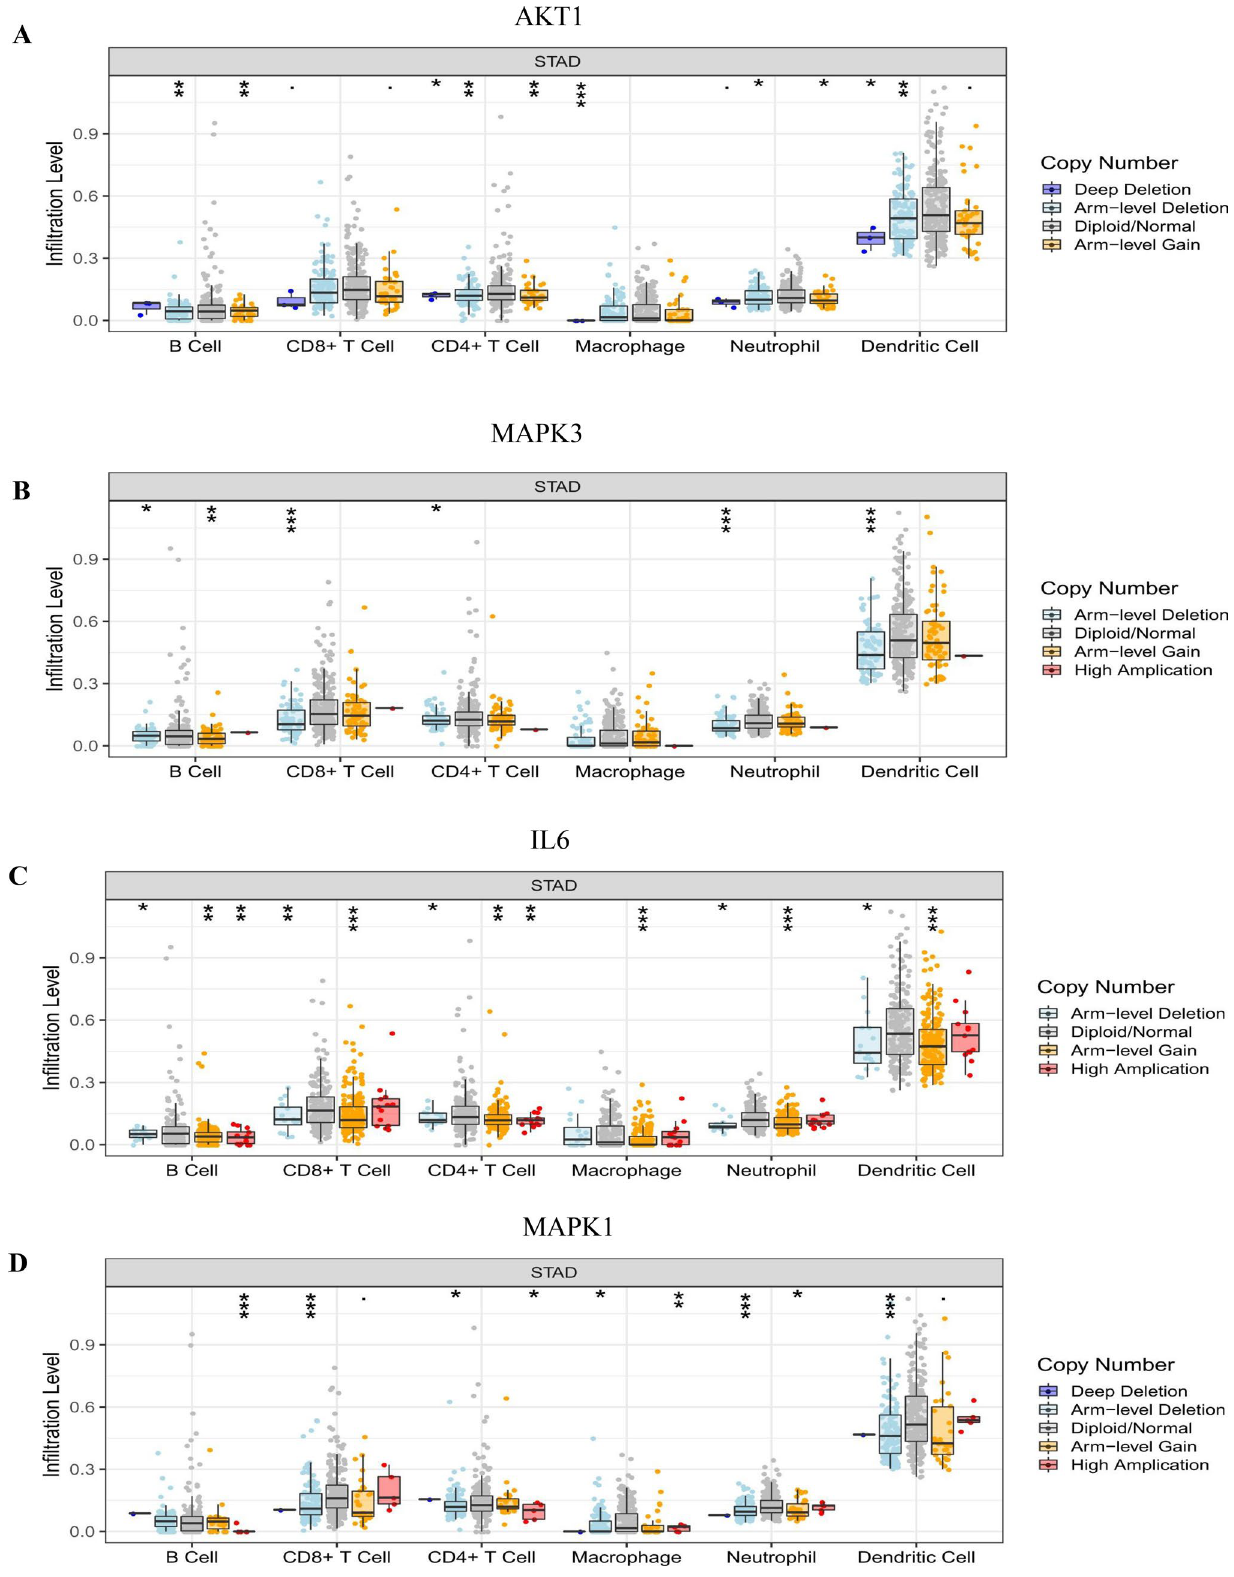
Figure 13. Immune cell infiltration of hub targets. Immune cell infiltration of ( A ) AKT1, ( B ) MAPK3, ( C ) IL6, ( D ) MAPK1, ( E ) EGFR, ( F ) SRC, ( G ) TNF, ( H ) CASP3, and ( I ) APP in the TIMER